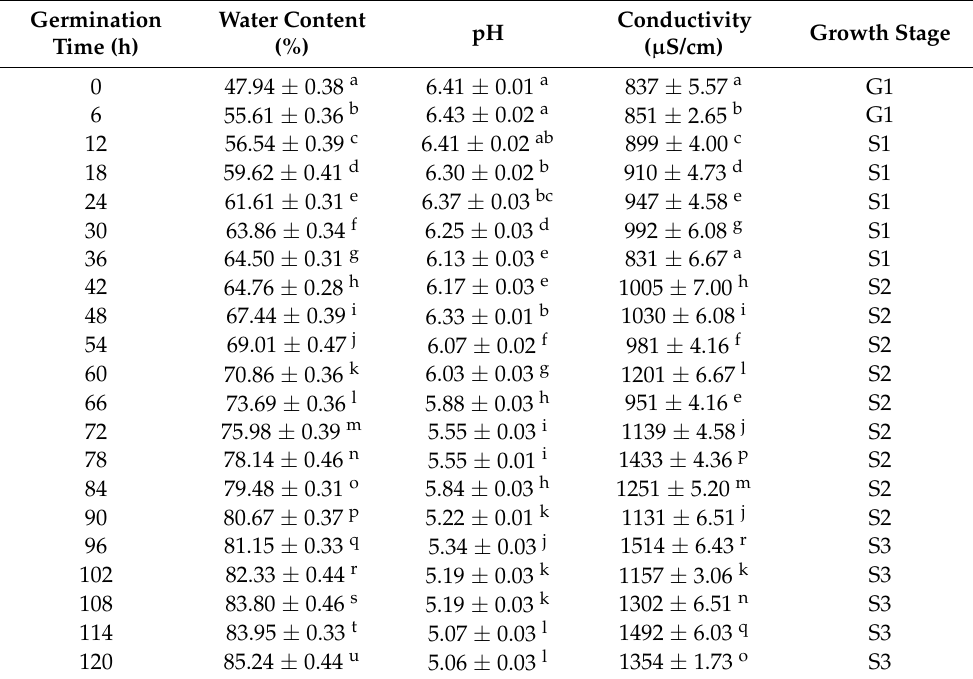
Table 1. Water content, pH, and conductivity values of mung bean sprouts.